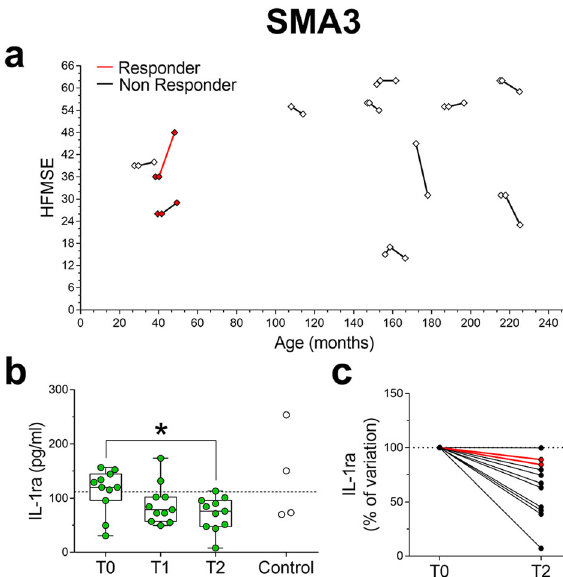
Fig. 4 IL-1ra levels are decreased by Nusinersen treatment in the CSF of SMA3 patients. a Spaghetti plots representing the HFMSE score of each SMA3 patient prior to treatment (T0, n = 11) at the fourth (T1, n = 11) and/ or sixth (T2, n = 11) injection of Nusinersen. b Levels of IL-1ra in the CSF of SMA3 patients prior to treatment (T0) and at the time of the fourth (T1) and the sixth (T2) injection of Nusinersen. Controls ( n = 4) were used as a reference for physiological baseline levels of cytokines. The dotted line represents the median of control samples. Data are shown as box and whisker plots representing median with interquartile range (IQR). Dots represent individual patients ’ values. * p < 0.05, compared to T0 (Wilcoxon matched-pairs signed ranks test). c Spaghetti plots showing variations of IL- 1ra levels in the CSF of SMA3 patients between T0 and T2. Cytokines variations are expressed as percentage of the T0 values (expressed as 100%). Patients were indicated as “ responders ” (red lines) or “ non- responders ” (black lines) to Nusinersen